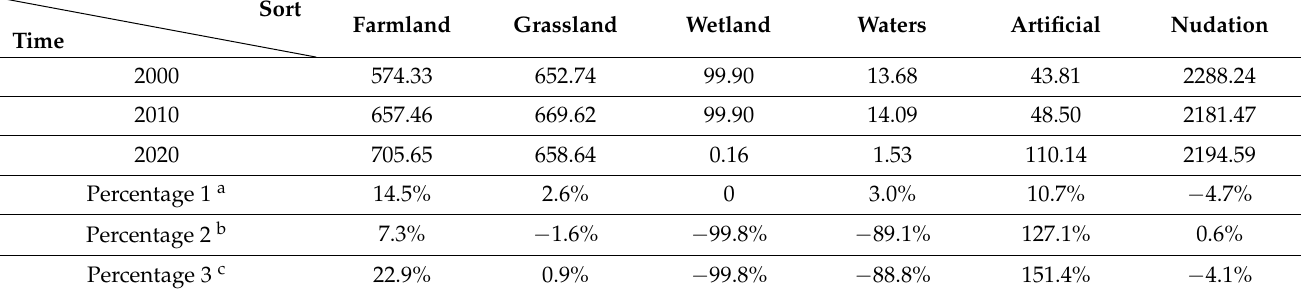
Figure 10. Spatio-temporal evolution of the land covers in the SFM–def region in 2000, 2010, and 2020. The red and magenta dotted lines delineate the central area of the subsidence funnels during the periods 2007–2010 and 2015–2020, respectively. Table 3. The area of different land covers in the SFM–def region in 2000, 2010, and 2020, obtained from Globeland